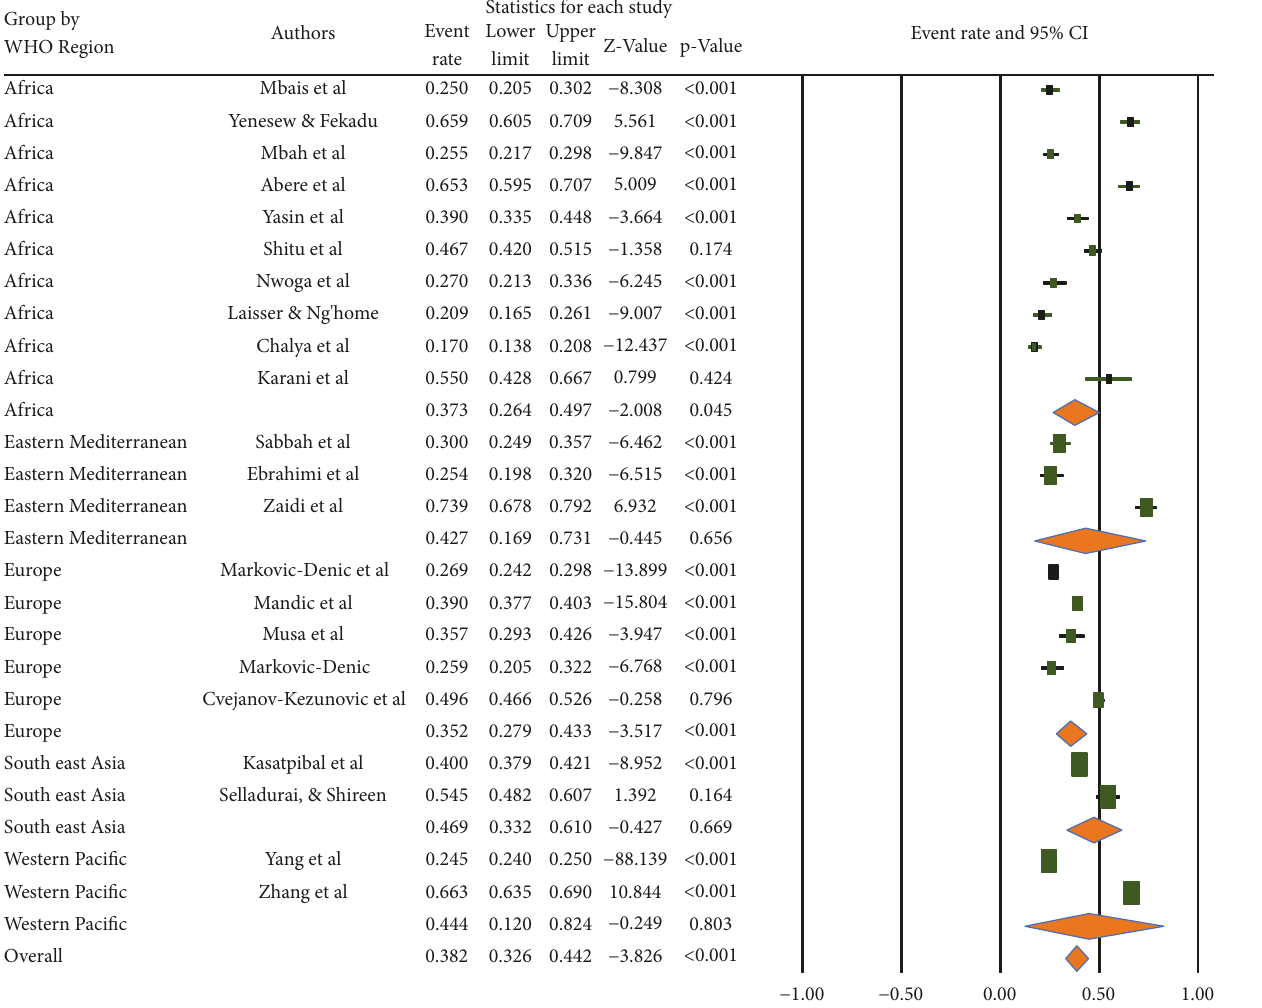
Figure 5: Prevalence of occupational exposure to blood and body fluids in the last 12 months among healthcare workers based on WHO